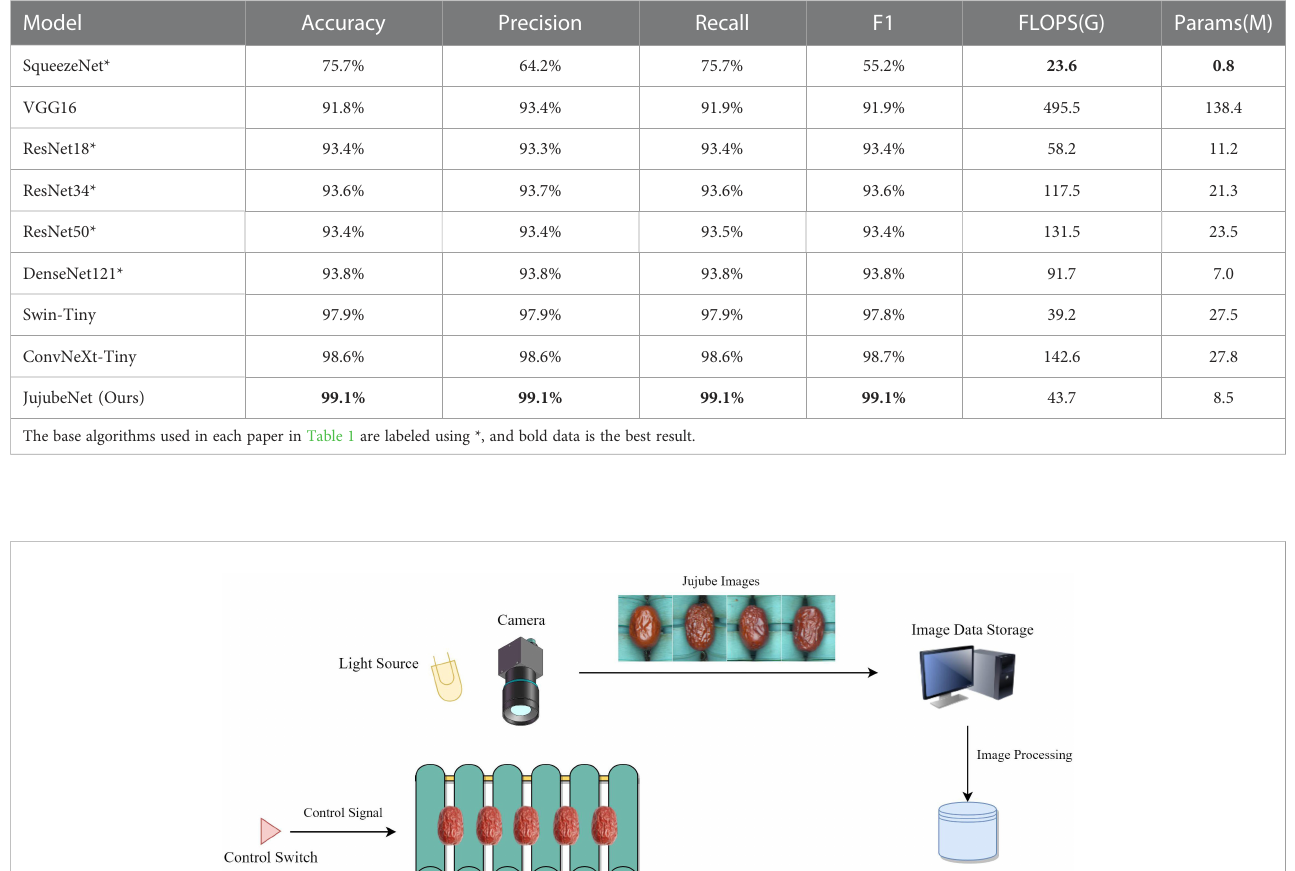
TABLE 1 Comparison of the performance for each model on the ‘ Jujube2000 ’ test set.